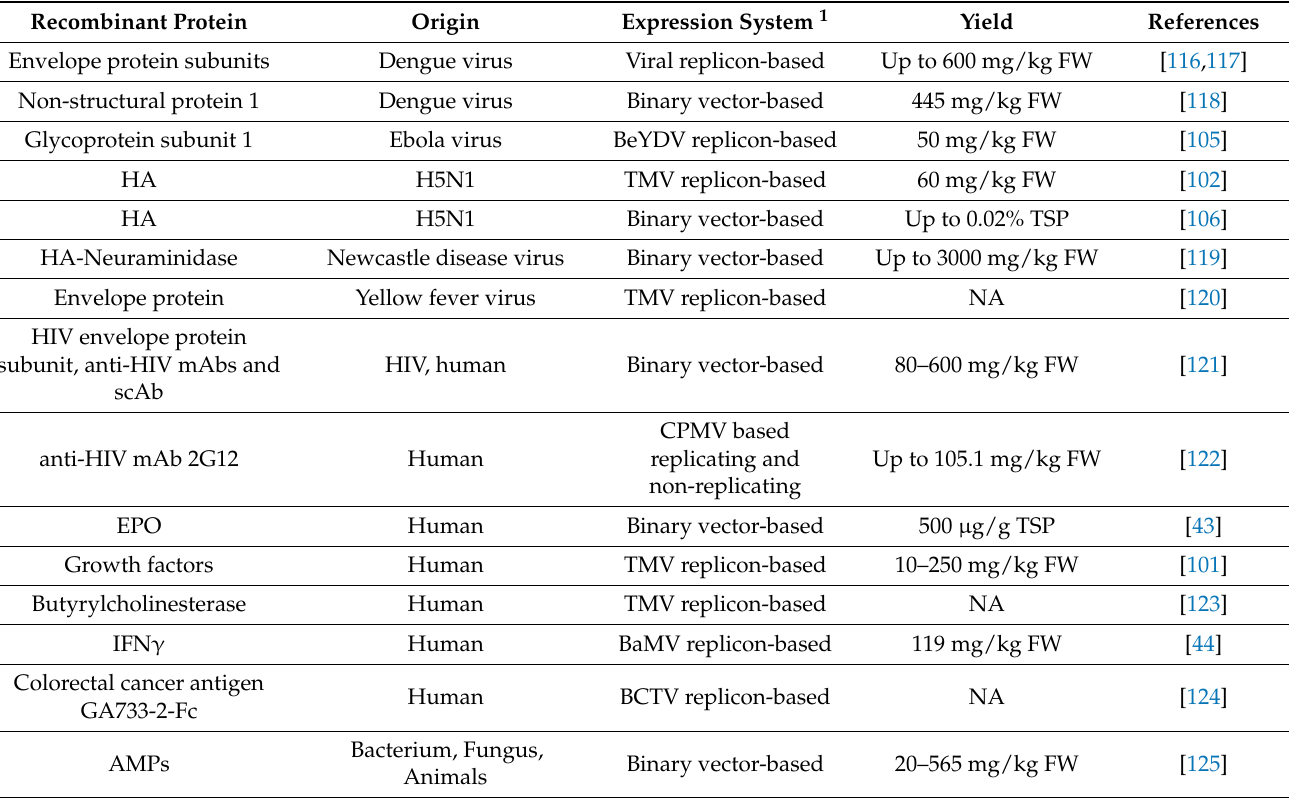
Table 3. Examples of transient expression of ER-accumulated recombinant pharmaceutical proteins in N. benthamiana